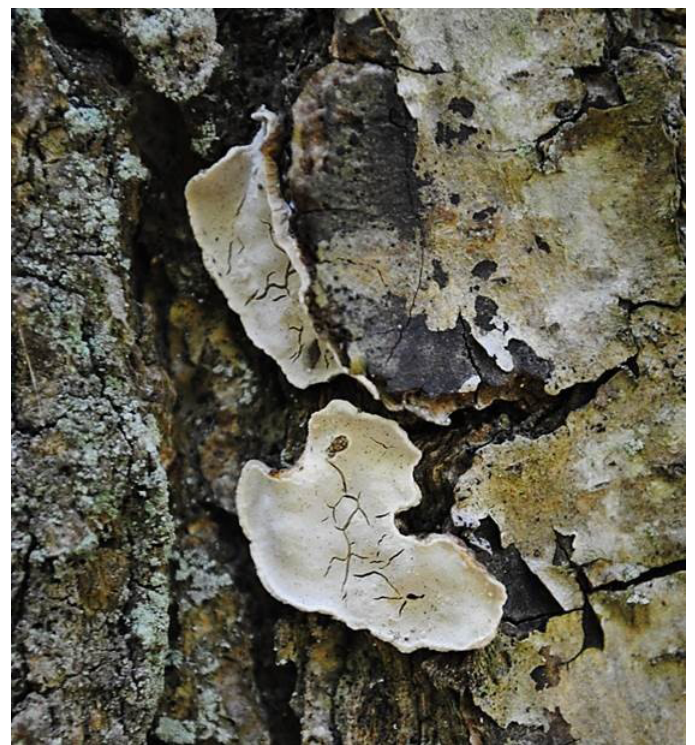
Figure 1 Basidiomata of Aleurodiscus disciformis from the Wolin National Park (June 13, 2017). Photography by